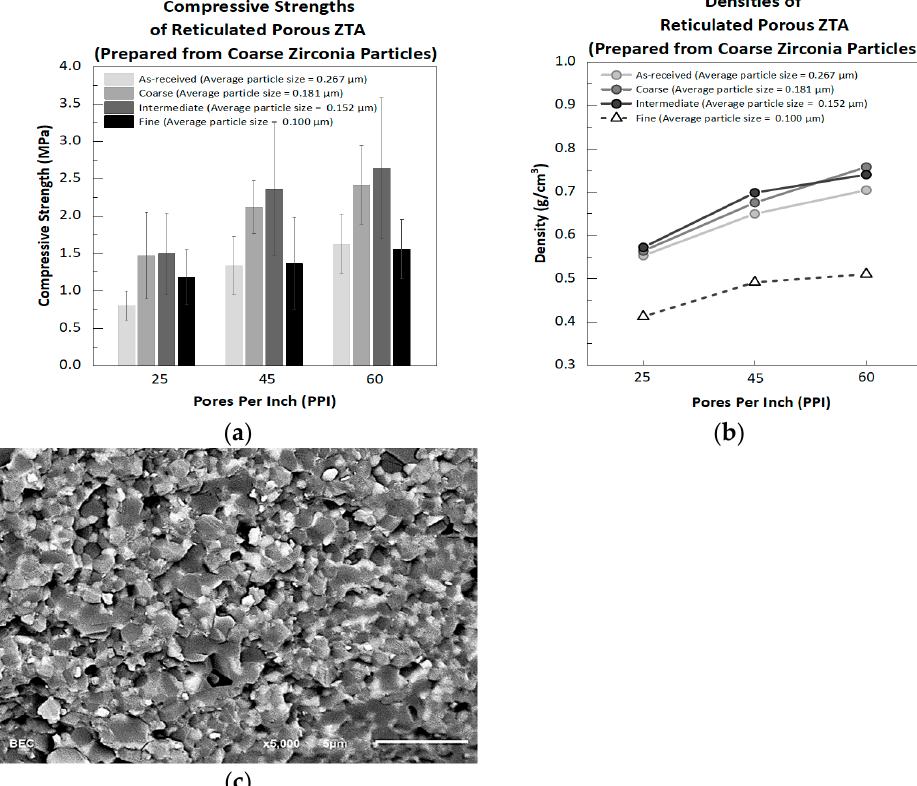
Figure 7. ( a ) Compressive strengths of reticulated porous ZTA specimens with various average particle sizes as controlled by adjusting the ball-milling time and ( b ) density, and ( c ) typical back scattered electron image of reticulated porous ZTA specimens when the average particle size was